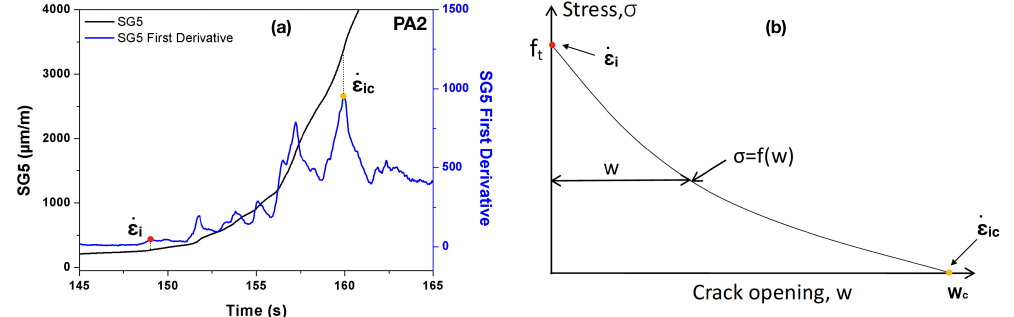
Figure 3. Determining the strain rate upon crack initiation using ( a ) the strain history data recorded in SG5 (shown for PA2 loaded at 22 µ m/s); and ( b ) a generic cohesive law.